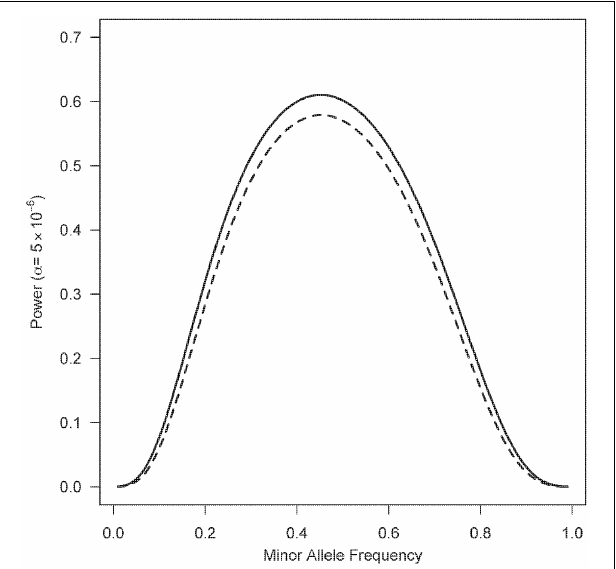
FIGURE 1 | Power estimates as a function of minor allele frequency of X-LRT and PIX-LRT. Each analysis is based on 1000 triads with affected sons and daughters. R B = 1 . 5, R 2 G 1 = R G 2 = 2 and among non-carriers boys are twice as likely to have the disease as girls. Solid line represents PIX-LRT. Dashed line represents XLRT. PIX-LRT uses a one degree-of-freedom combined test, while X-LRT uses a two degree-of-freedom